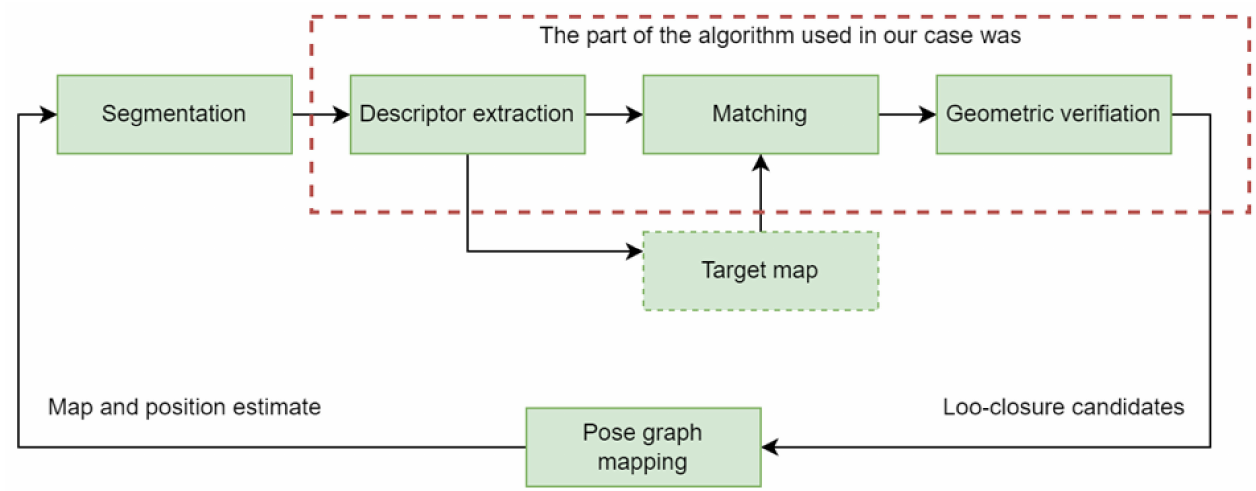
Figure 5. SegMatch algorithm